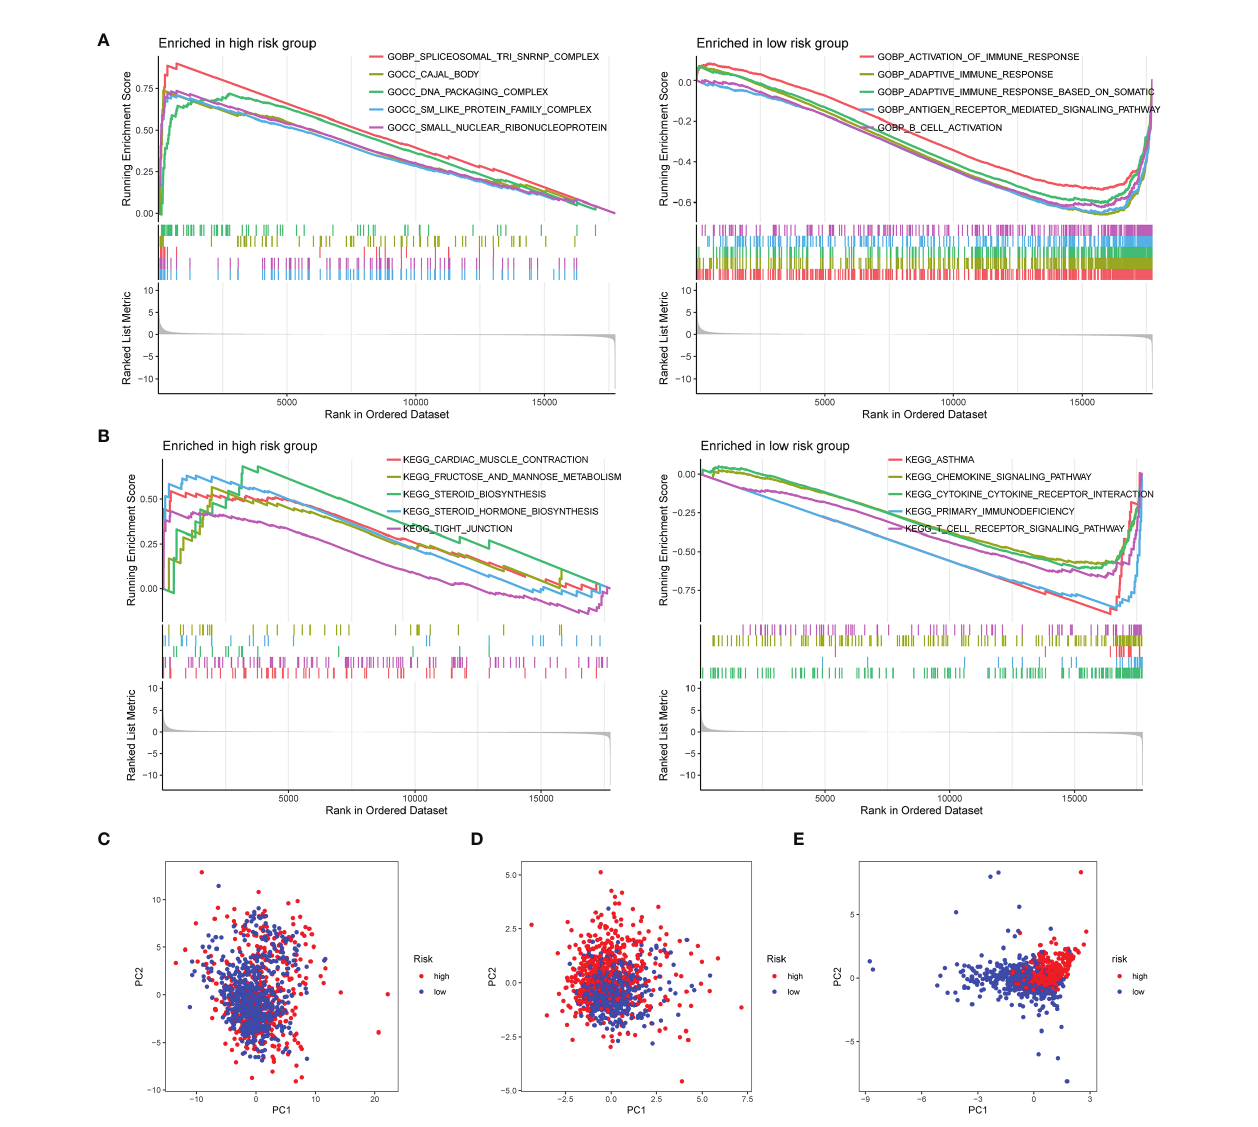
FIGURE 6 | GSEA of risk score-related signaling pathways. Enriched GO terms (A) and enriched KEGG pathways (B) between high- and low-risk groups. (C) PCA for the total mRNA expression pro fi le. (D) PCA for glycosyltransferase gene expression pro fi le. (E) PCA based on 9 selected glycosyltransferase genes. GSEA, Gene Set Enrichment Analysis; GO, Gene Ontology; KEGG, Kyoto Encyclopedia of Genes and Genomes; PCA, principal component